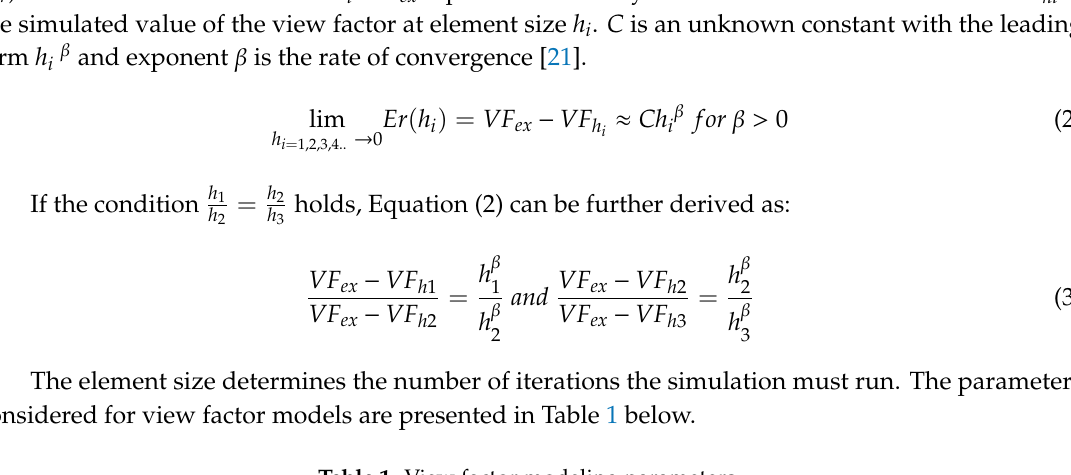
Table 1. View factor modeling